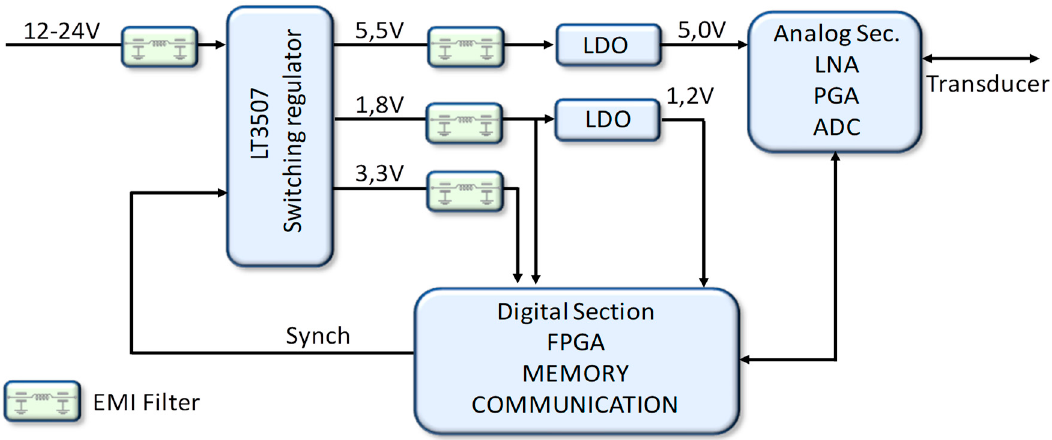
Figure 1. Simplified power tree of the Doppler system employed in the tests. The main switching regulator has three synchronous sections used to generate the powers for the analog and digital parts of the board. The regulator is synchronized by a signal from the local field-programmable gate array (FPGA). Electromagnetic interference (EMI) filters and further low dropouts (LDOs) are used at the input and outputs of the regulator.